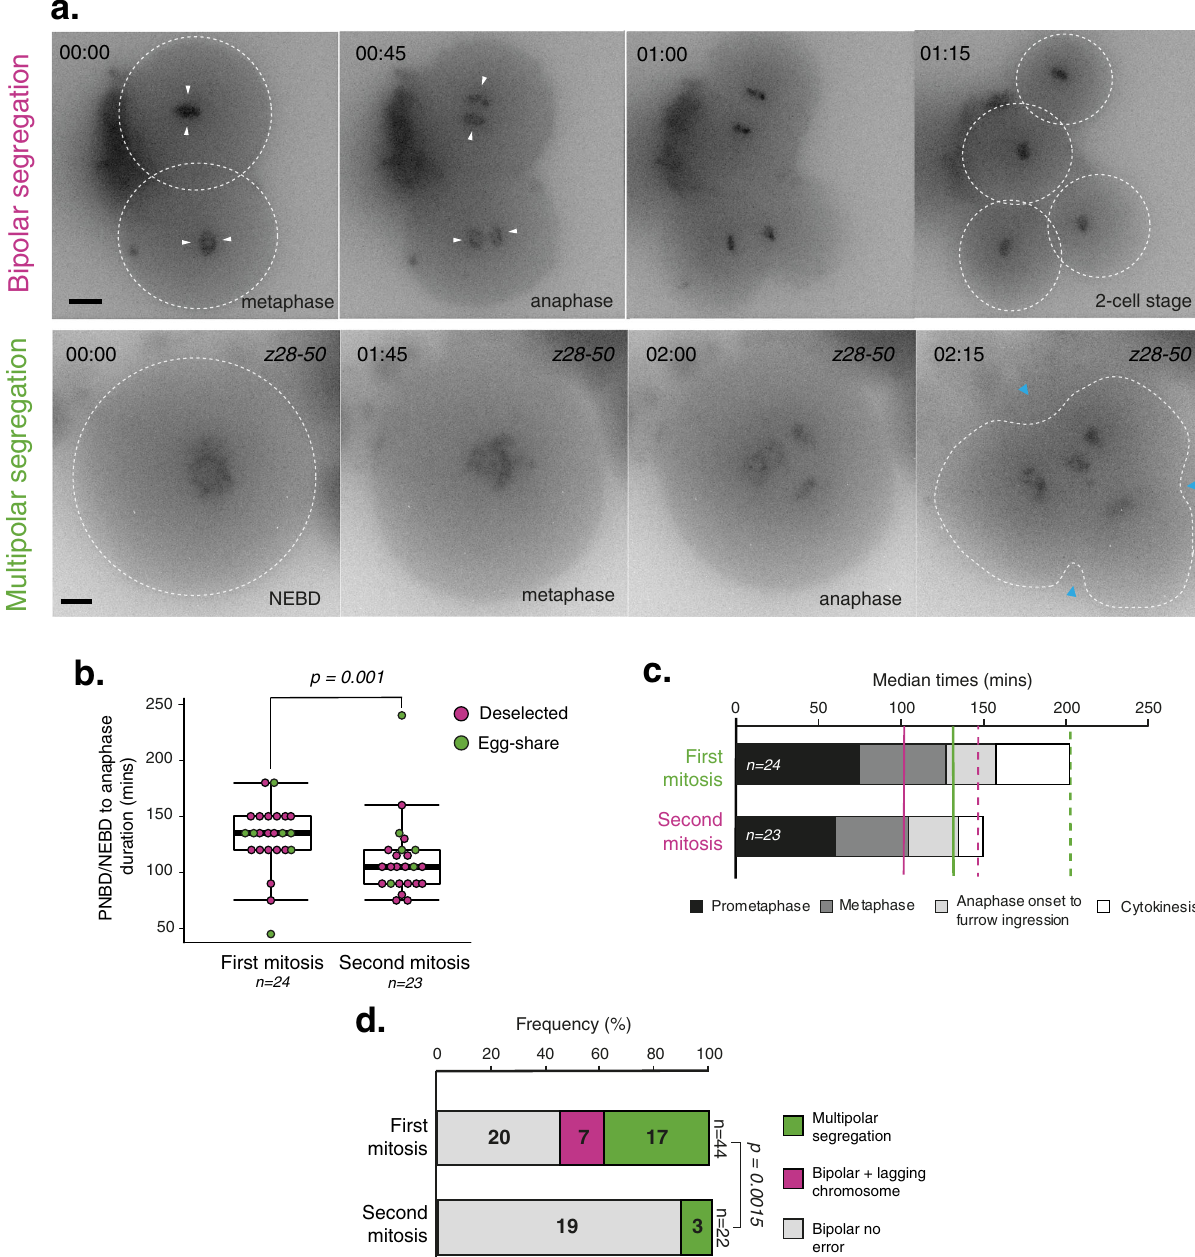
Fig. 5 | Comparing the fi rst and second mitotic divisions of human embryos. a Time lapse imaging of representative deselected human embryos progressing through the second embryonic mitosis with bipolar division (top) and multipolar division (below). White arrows indicate bipolar segregation and white circles indicate celloutline.ChromosomesarevisualisedusingSiR-DNAdye,timeinhours:mins.Blue arrowsindicateonsetofcleavagefurrowingression,scalebar20 µ m. b Quanti fi cation of the timing from PNBD/NEBD to anaphase onset of deselected and egg-sharer embryos undergoing the fi rst or second mitosis. P value from a two-sided Mann – Whitney U -test. N refers to the number of fi lmed embryos included in dataset. Boxandwhiskerplotsrepresentminimum,lowerquartile,median,upperquartileand